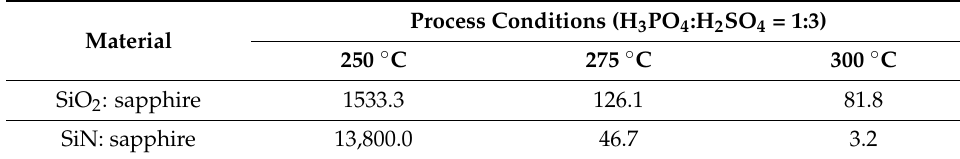
Table 7. Corrosion selection ratio of different